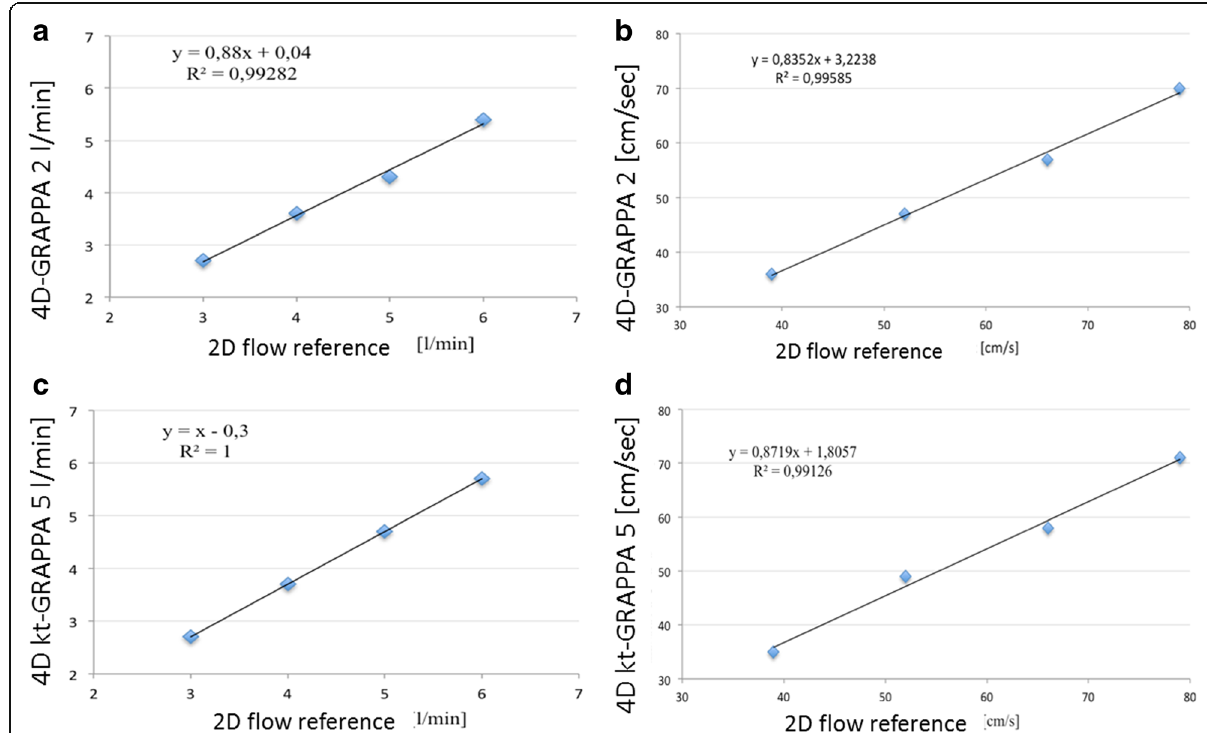
Fig. 5 Scatter plots of the correlation between flow volumes and mean flow velocity measured with the 4D flow GRAPPA2 and k-t- GRAPPA5 sequences and the 2D flow sequence (reference) in pulsatile flow. a , c Flow volume [L/min]. b , d Mean flow velocity [cm/s]. 2D, two-dimensional; 4D, four-dimensional; cm/s, centimetres per second; GRAPPA, generalised autocalibrating partially parallel acquisition; L/min, litres per